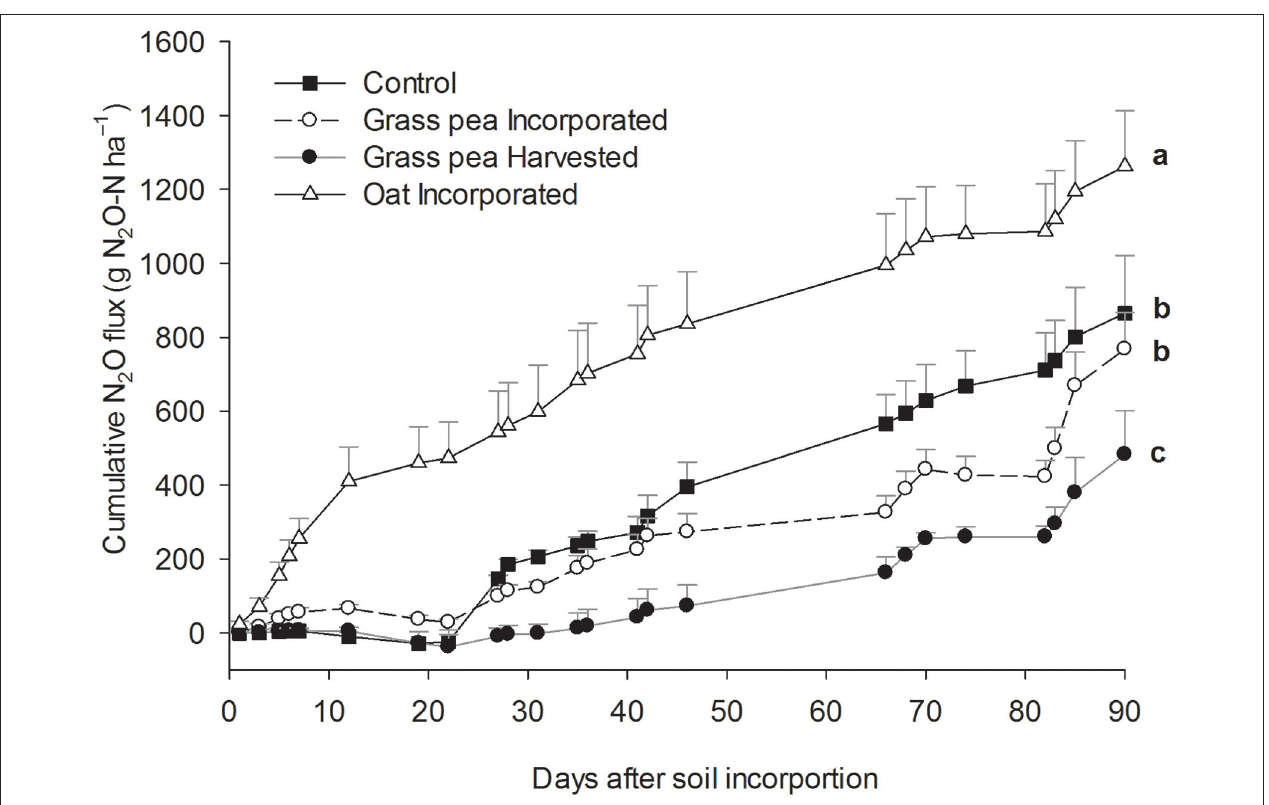
FIGURE 2 | Cumulative estimates of nitrous oxide (N 2 O) emissions during the 90 day study period. Error bars represent standard error ( n = 3).